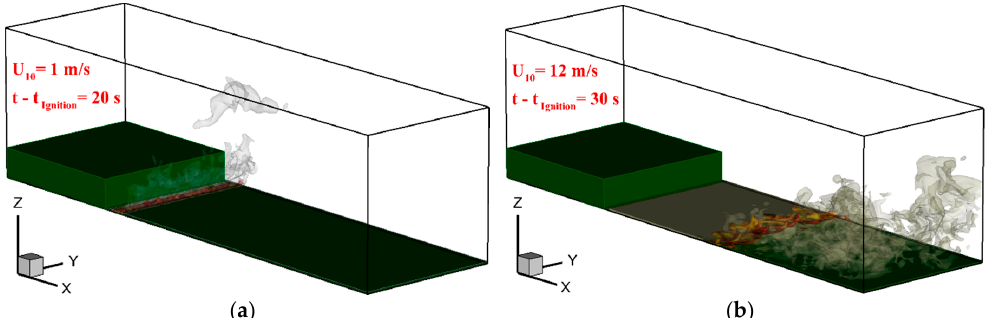
Figure 9. Three-dimensional (3D) views of grassland fire spread downstream of a canopy obtained for U 10 = 1 m/s ( a ) and U 10 = 12 m/s ( b ), 20 s and 30 s, respectively, after ignition. Fire is visualized by an isovalue surface of the soot volume fraction (10 − 6 ) colored by the gas temperature and by an isovalue surface of the water mass-fraction (0.00075) in grey shades with 75% transparency.